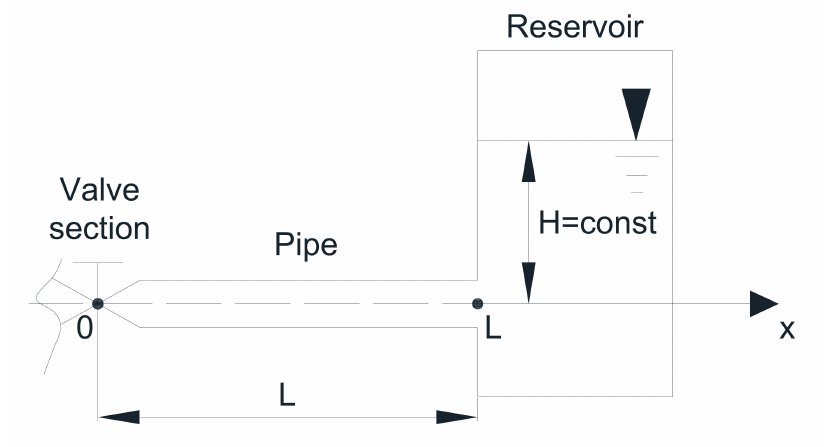
Figure 1. The reservoir–pipe–valve